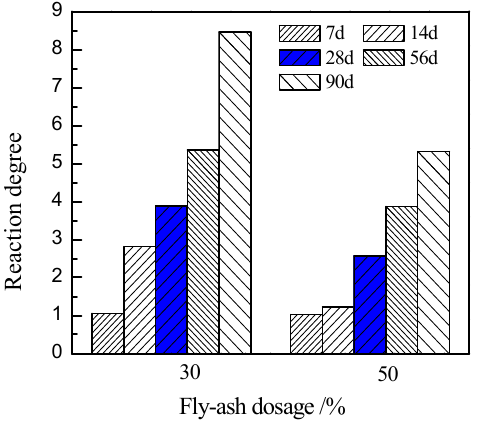
Figure 8. Reaction degree of fly ash in blended pastes.